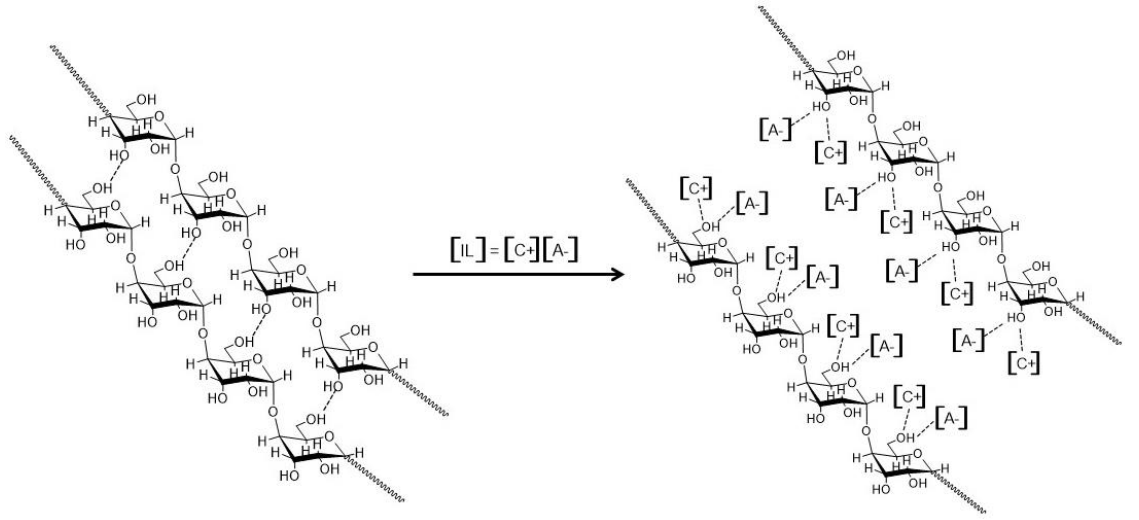
Figure 5. H-bond rupture mechanism by ionic liquids. IL stands for ionic liquid, C+ is the cation moiety, while A − is the anion one